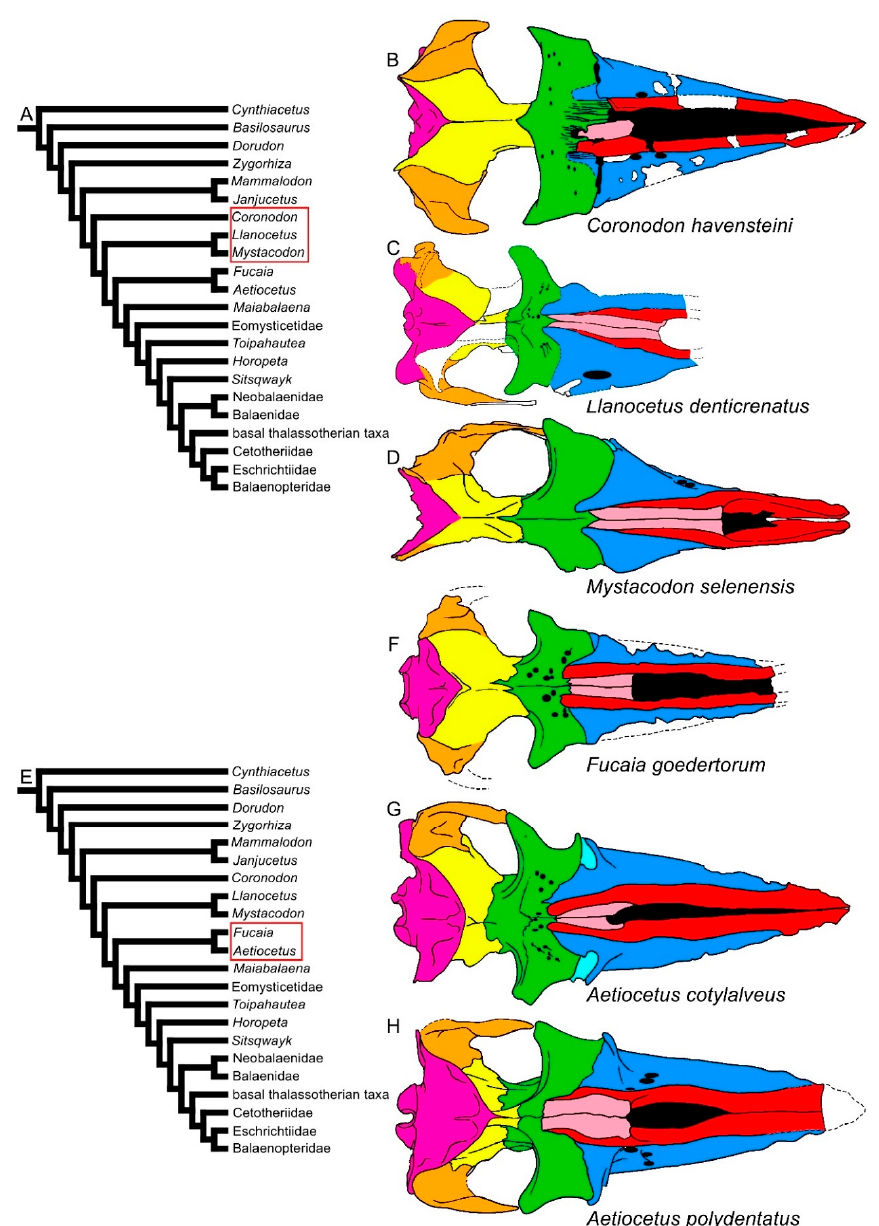
Figure 8. Diversity of the skull in dorsal view in basilosaurine and dorudontine archaeocetes and in mysticetes. ( A ) Phylogenetic relationships among archaeocetes and mysticetes showing the ar- chaeocete branching (red ellipsis). ( B ) Skull of Basilosaurus cetoides . ( C ) Skull of Dorudon atrox . ( D ) Skull of Zygorhiza kochii . ( E ) Phylogenetic relationships among archeocetes and mysticetes showing the ramus leading to Mammalodontidae (red ellipsis). ( F ) Skull of Mammalodon colliveri . ( G ) Skull of Janjucetus hunderi . Not to scale. The skulls are represented as if they shared the same condylobasal length.